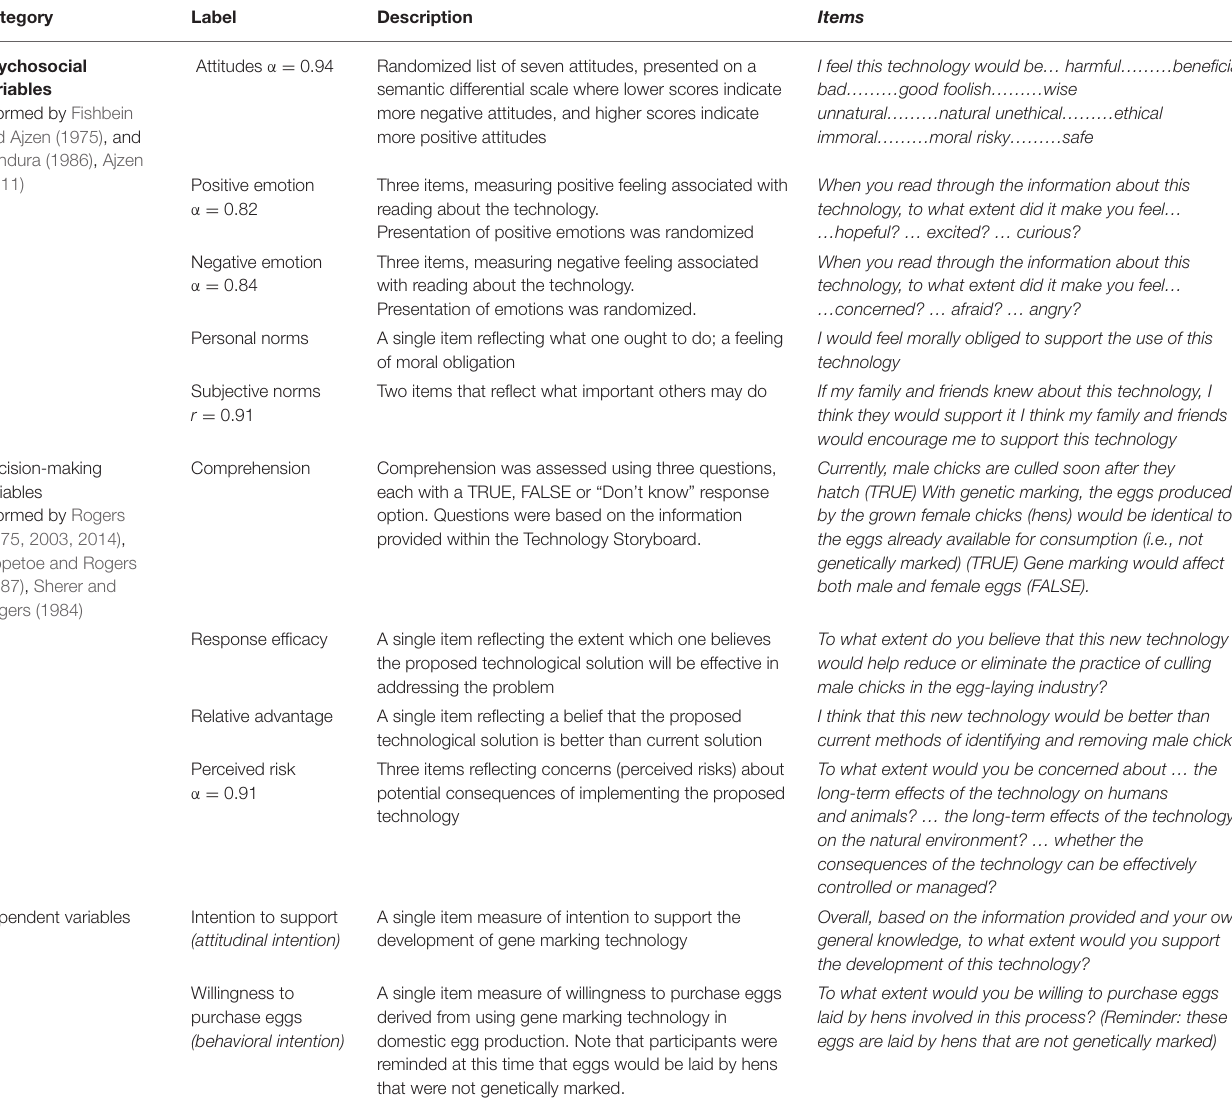
TABLE 1 | Constructs and example items measured in the survey. Category Label Description Items Psychosocial Attitudes α = variables Informed by Fishbein and Ajzen (1975), and Bandura (1986), Ajzen (2011)